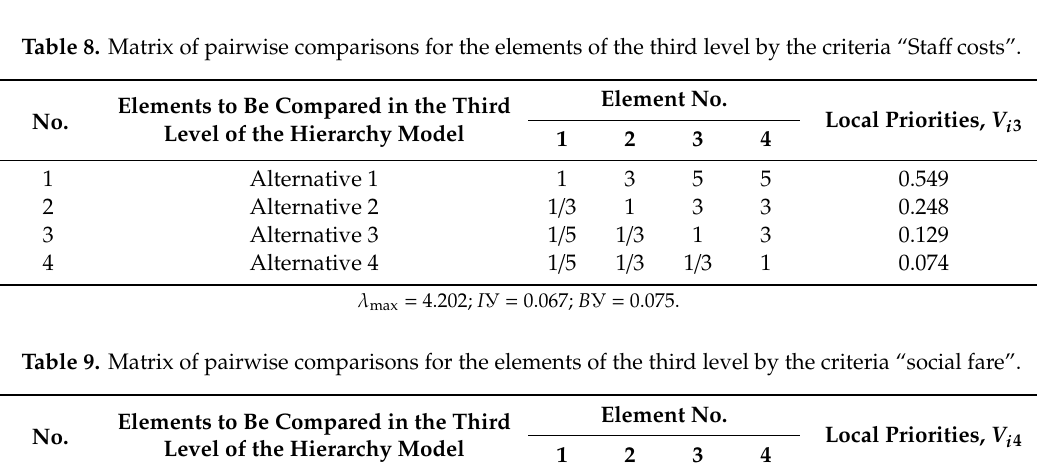
Element No. Local Priorities, V i 4